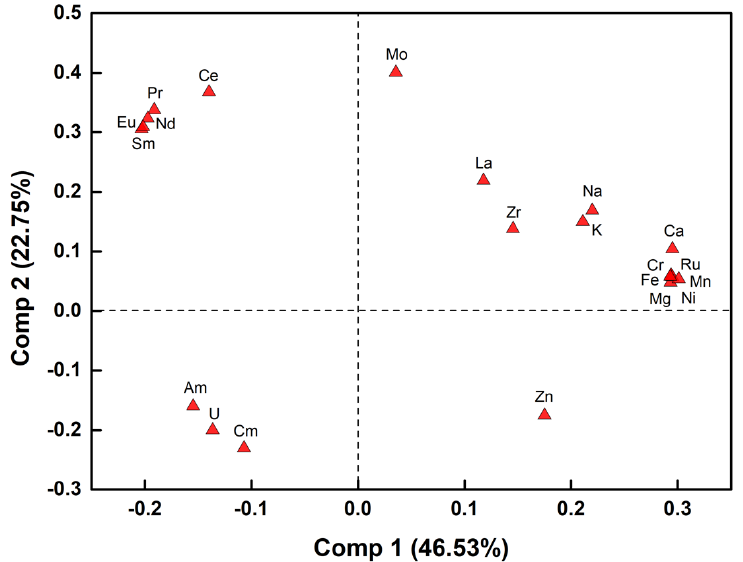
Figure 1. The loadings plot for PCA model constructed for reference data on the content of the elements.